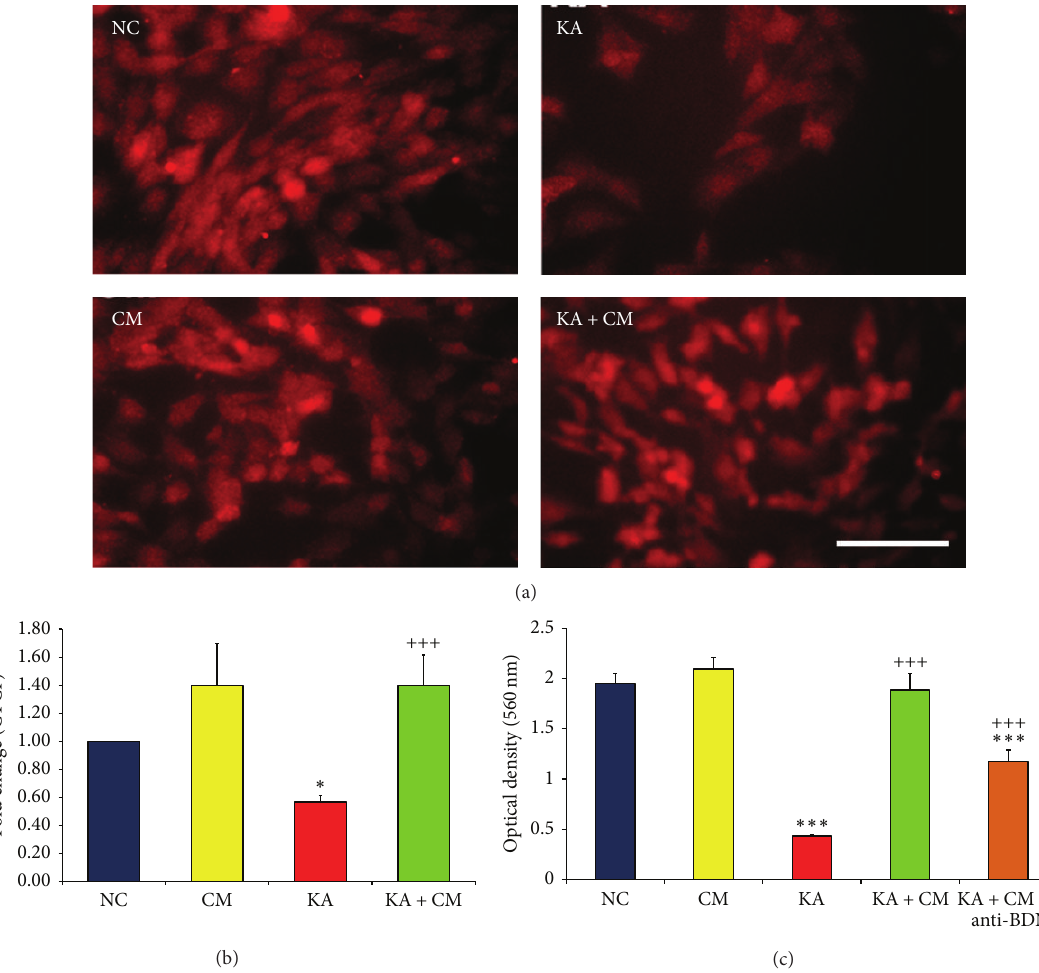
Figure 4: HEK-CM stimulates host’s cell survival factors BDNF and Bcl-2. (a) Photomicrograph represents the expression of BDNF in different treatment groups. Scale Bar 200 𝜇 m. (b) Bar diagram signifies the fold changes in BDNF fluorescence intensity as compared to NC. (c) MTT Assay. Bar diagram represents the viable cells in different treatment groups. Neutralization of BDNF in HEK-CM diminishes the neuroprotective potential of HEK-CM against excitotoxicity. Nevertheless, significant neuroprotection was observed in KA + CM with anti-BDNF group as compared to KA group suggesting that other growth factors/cytokines in CM might be contributing to the observed neuroprotection. Normal control (NC), normal control exposed to HEK conditioned medium (CM), Kainic acid alone treated (KA), Kainic acid and HEK conditioned medium cotreated (KA + CM), and Kainic acid and BDNF neutralized HEK conditioned medium cotreated (KA + CM with anti-BDNF). Data represented as mean ± SEM. ∗ indicates comparison between NC and treatment; + indicates comparison between KA lesion and treatment; ∗ 𝑃 < 0.05 ; ∗∗∗ 𝑃 < 0.001 ; +++ 𝑃 < 0.001